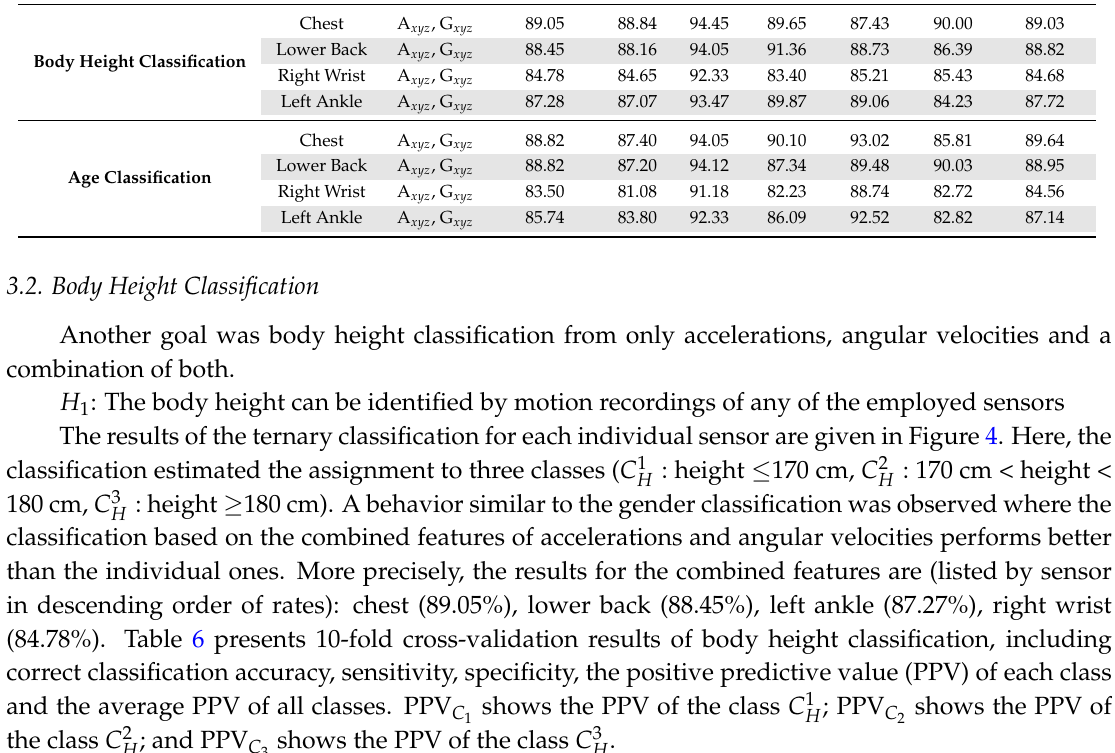
: height ≤ 170 cm, H